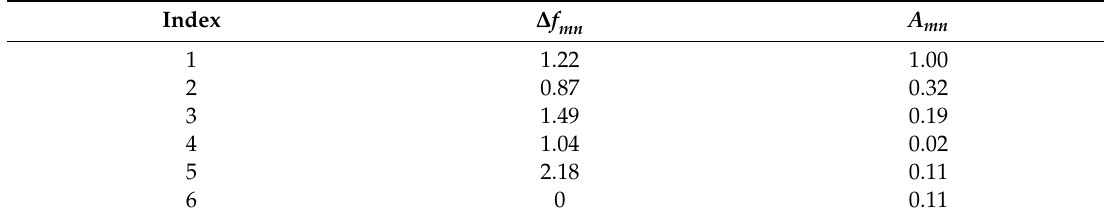
Table 1. Frequency offset and the amplitude offset.